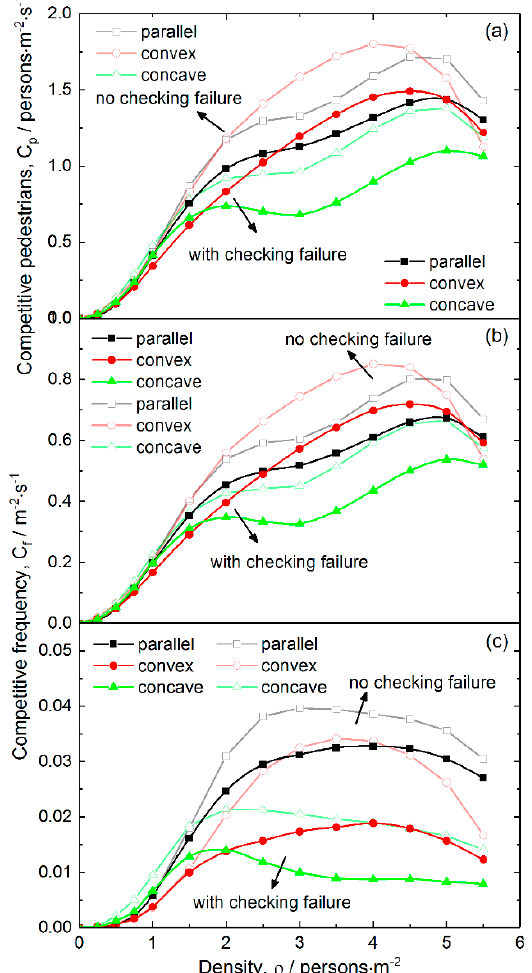
Figure 6. Competitive intensity as a function of pedestrian density for the three layouts of inspection points: ( a ) Competitive pedestrian-time, ( b ) two-person competitive frequency and ( c ) three-person competitive frequency. The checking failure probability and delay are 0.08 and 3 s, respectively. The open symbols are the results obtained under conditions without checking failure.